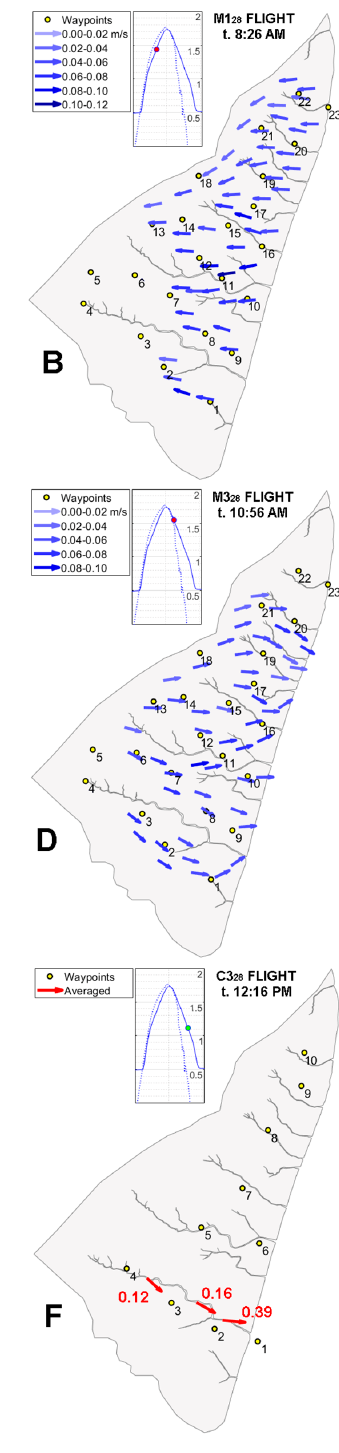
Figure 9. Velocities calculated in the field during the flights for the survey performed on the 28th of October. The blue arrows describe the velocities calculated from the dye clouds, interpolated over the marsh for the M 28 flights, and instantaneous for the C 28 flights. The red arrows are the average velocities in each waypoint, described by numbered yellow dots. The dots (red for the marsh, green for the creeks) represent the reported central time of the UAV survey. The subfigures show the flow field for: ( A ) The first flight over the channels (C1 28 ); ( B ) The first flight over the marsh (M1 28 ); ( C ) The second flight over the marsh (M2 28 ); ( D ) The third flight over the marsh (M3 28 ); ( E ) The second flight over the channels (C2 28 ); ( F ) The third flight over the channels (C3 28 ).